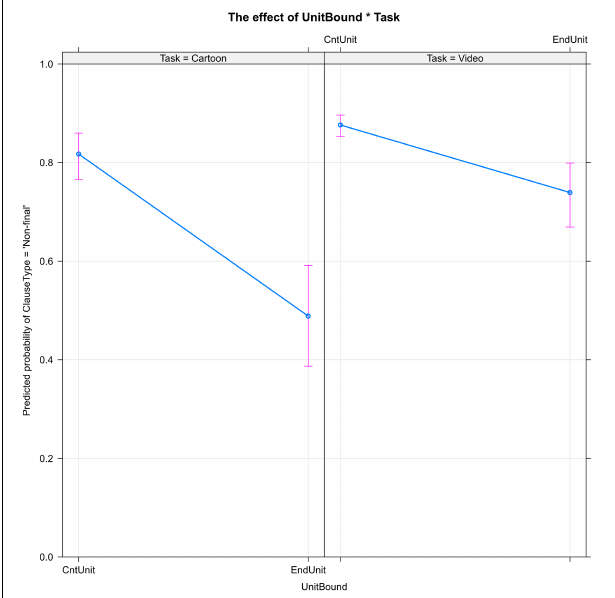
TABLE 4 | Results of model (predicted level of Clause Type = ‘Non-final’).